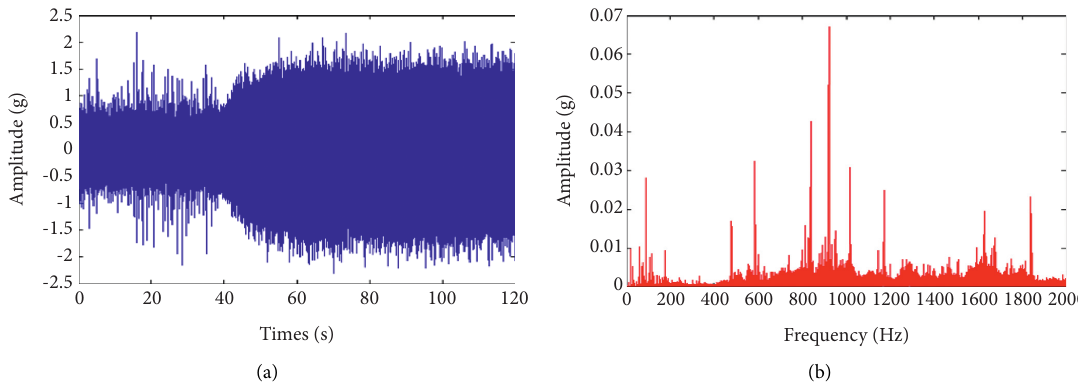
Figure 17: Experimental acceleration values at measuring point 3. (a) Experimental results for time domain acceleration at measuring point 3. (b) Experimental results for frequency domain acceleration at measuring point 3.